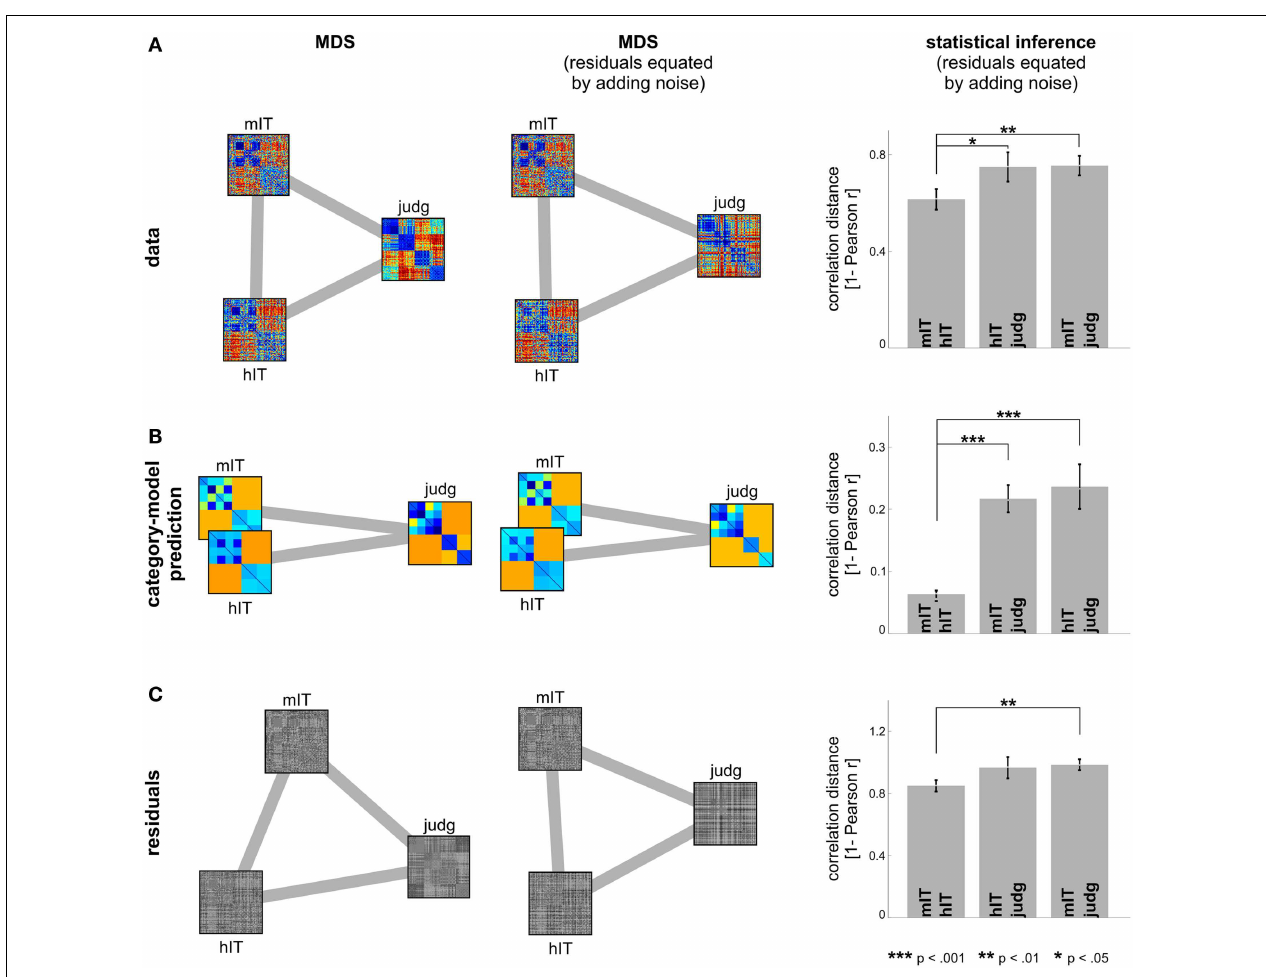
same analysis applied to the predicted RDMs of the category-model ( Figure 5 ) suggests that hIT and mIT are very similar in terms of the categorical divisions they emphasize and significantly more similar to each other in this respect than either of them is to human judgments. (C) The same analysis applied to the residual RDMs of the category-model shows a weak reflection of the category-model results: hIT and mIT appear slightly more similar to each other than either of them is to the human